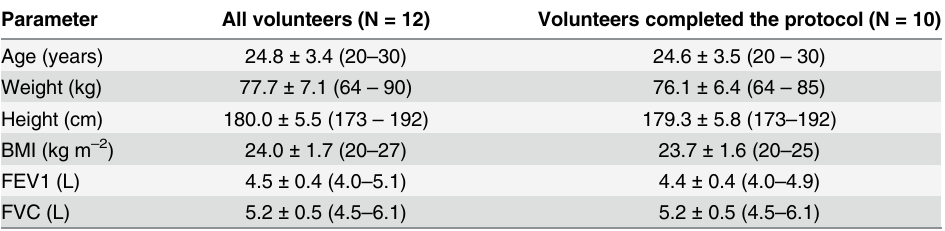
Table 1. The basic characteristics of the group of volunteers involved in the breathing experiment.